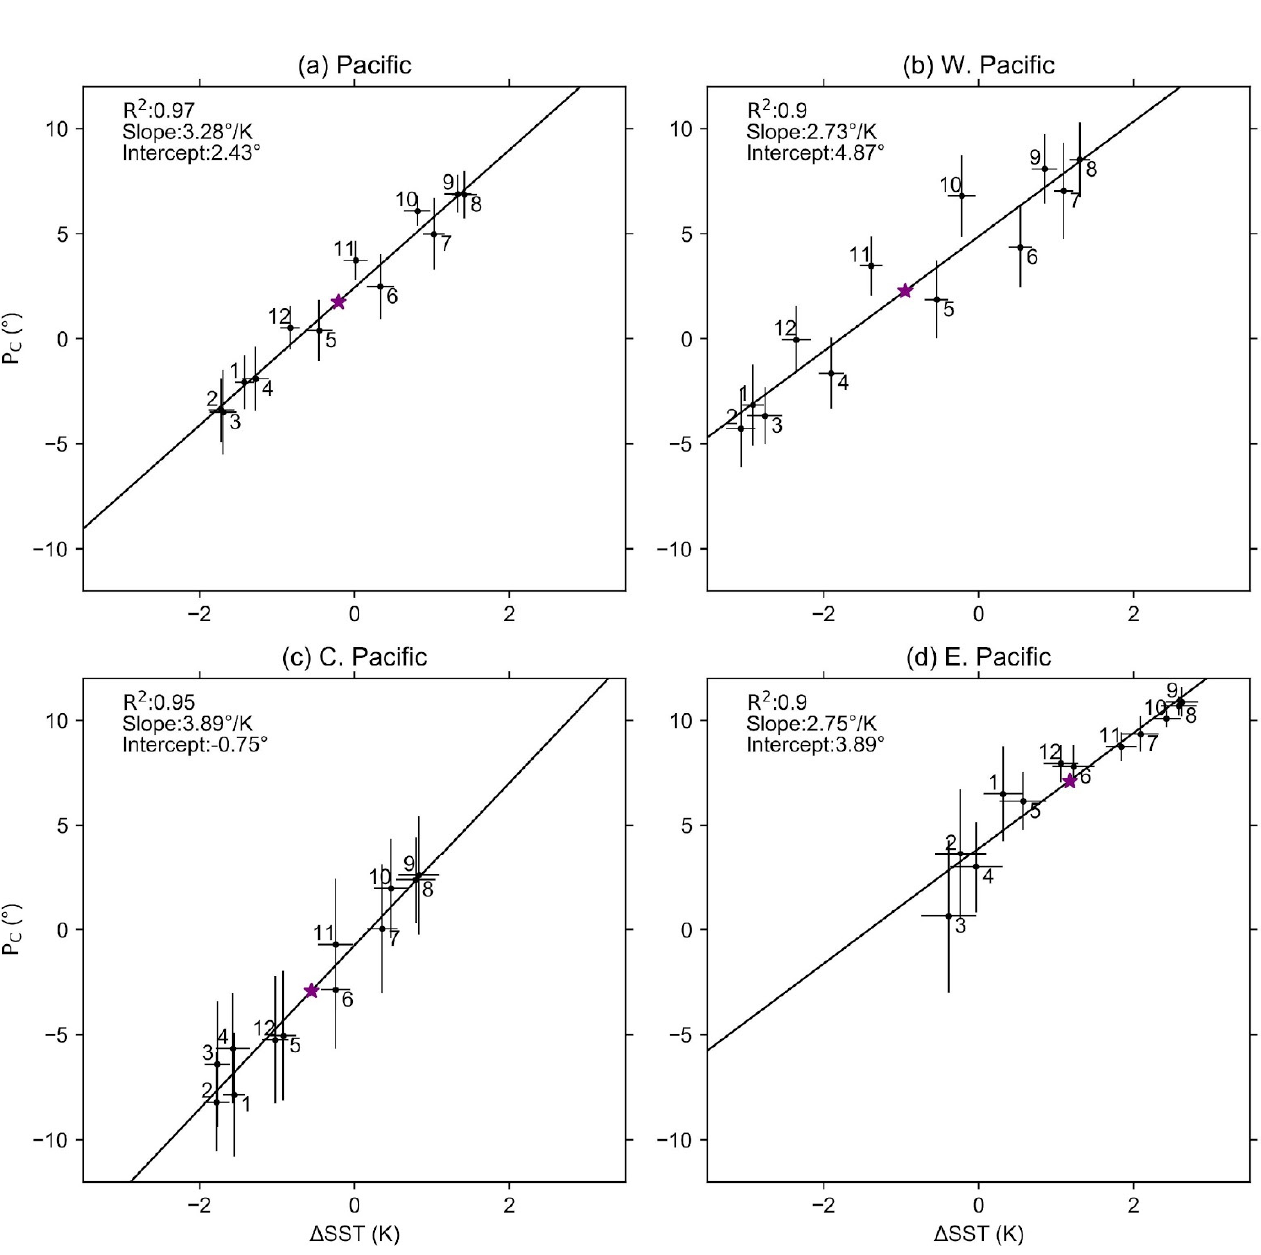
Figure 2. Observed seasonal cycle of the ITCZ position and interhemispheric SST contrast within each sector of the Pacific. The 12 crosses represent the 21-year mean precipitation centroid and SST contrast for each month of the year, the length of each cross equals 1 standard deviation from the mean, and the star is the annual average, as in Figure 1. Again, note the strong correlation and difference in sensitivity in each sector. Figure 1c is identical to Figure 2a but is reproduced for ease of comparison.